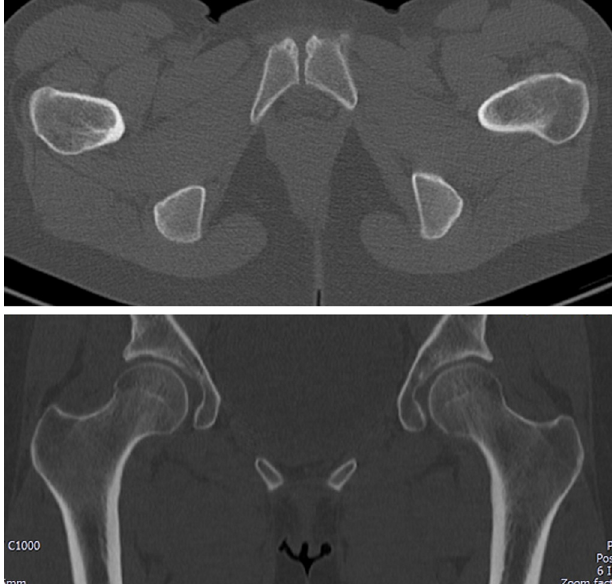
Figure 4. Pelvic CT-scan (A (cid:1) axial view, B (cid:1) coronal view) at twelve months, showing fracture union and no signs of